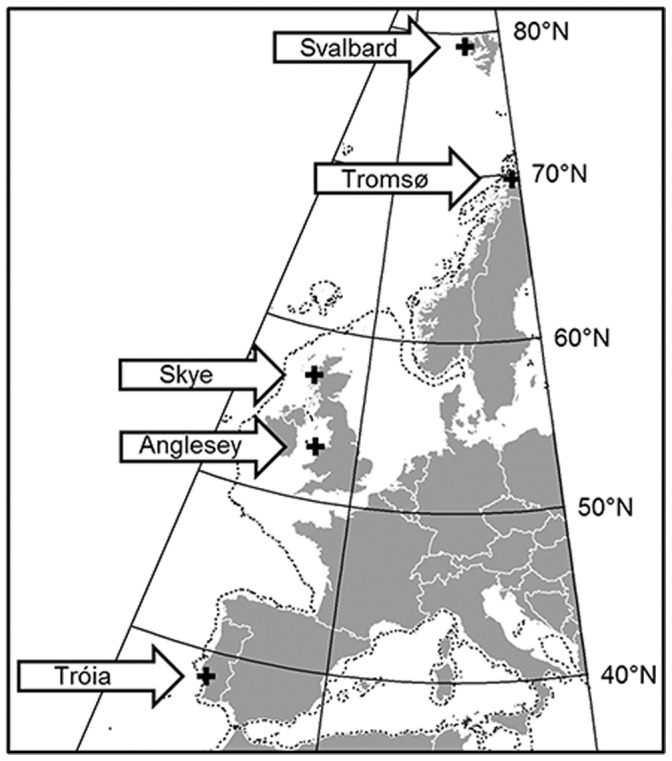
Map of Western Europe to show the location of the various collection sites used in the study.Further details are given in Table 1.